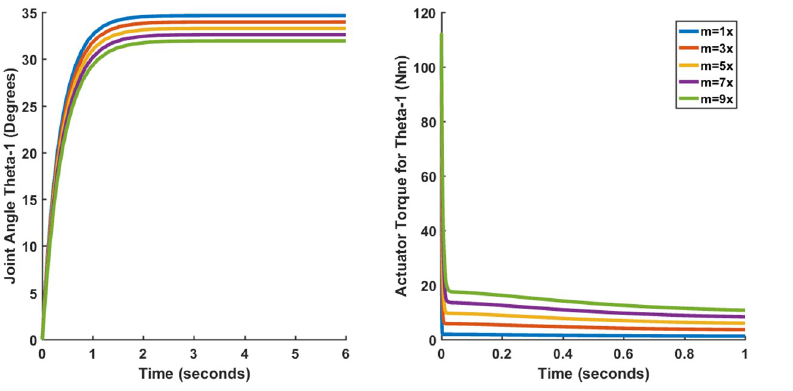
Fig 15. Performance of LQR (Case I) under mass